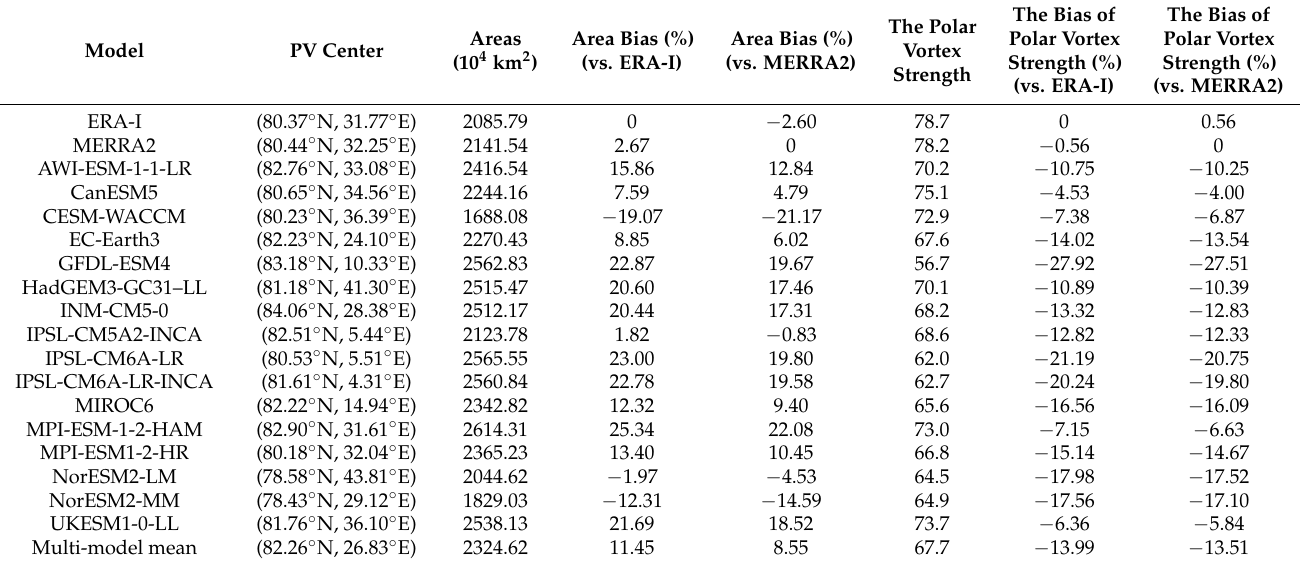
Figure 1. ( a ) Edge (contour lines) and center (shaped dots) of climatological polar vortex averaged over the isentropic levels between 430 – 600 K during December – January – February (DJF) for the period 1980/81 – 2013/14 based on ERA-Interim, MERRA2, simulations of 16 CMIP6 models and multi-model mean. ( b ) Same as ( a ) except that it is presented as a Mercator projection. Table 2. Center position, strength and size of the polar vortex from two reanalysis datasets and model simulations, and biases of the polar vortex strength and area in various model simulations compared with Reanalysis (the averaged between ERA-I and MERRA2), ERA-I and